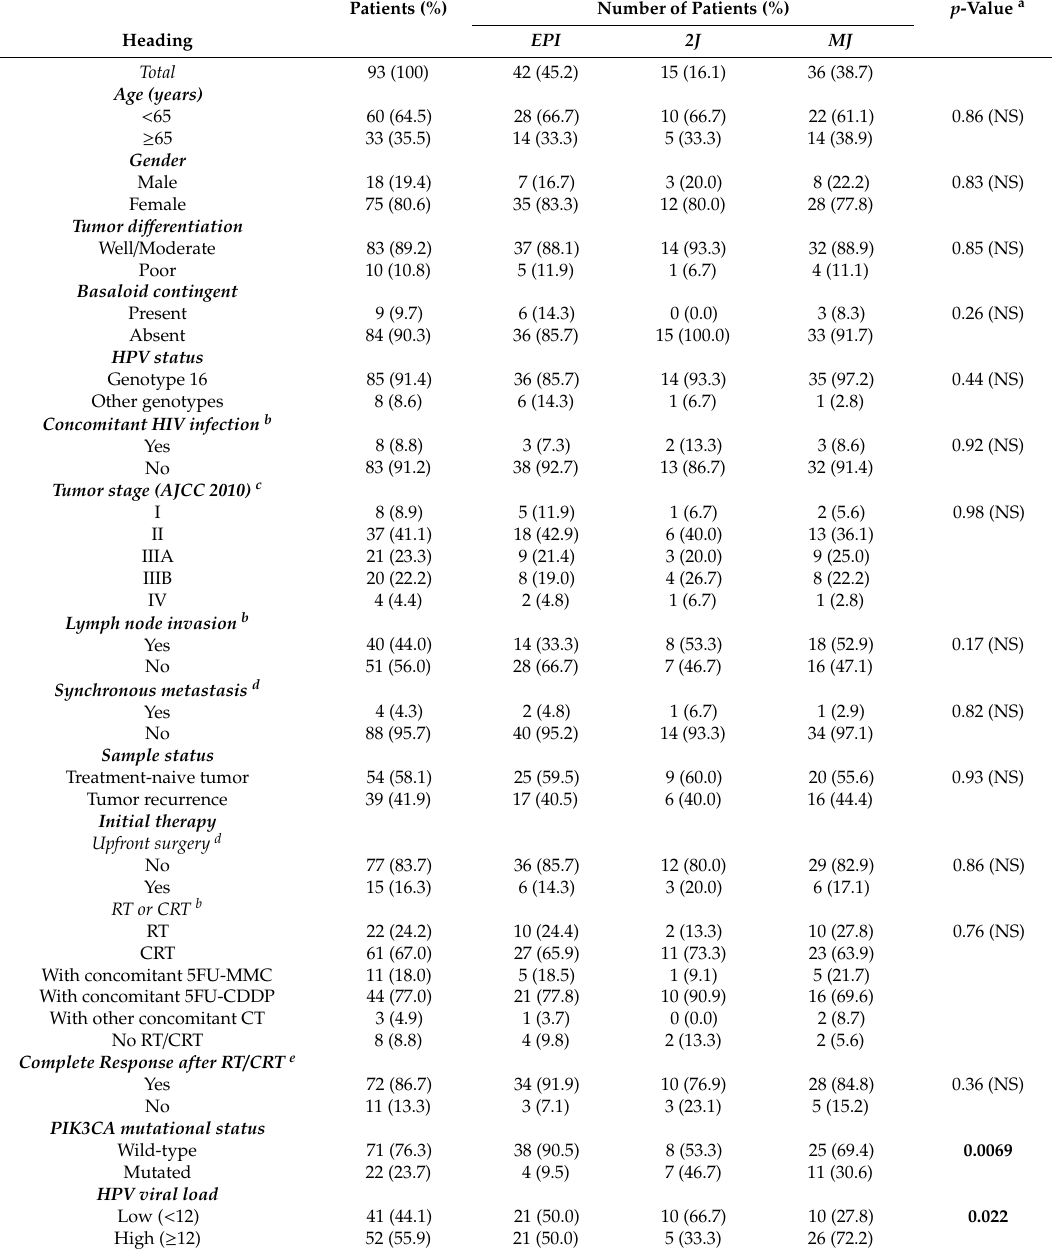
a Chi-Square Test; p values for comparison of the EPI group vs. the 2J group vs. the MJ group for each parameter; b Data available for 91 patients; c Data available for 90 patients; d Data available for 92 patients; e Data available for 83 patients; CDDP: cisplatin; CRT: chemo-radiation; CT: chemotherapy; MMC: mitomycin C; RT: radiation therapy. NS: not significant, Significant results are displayed in